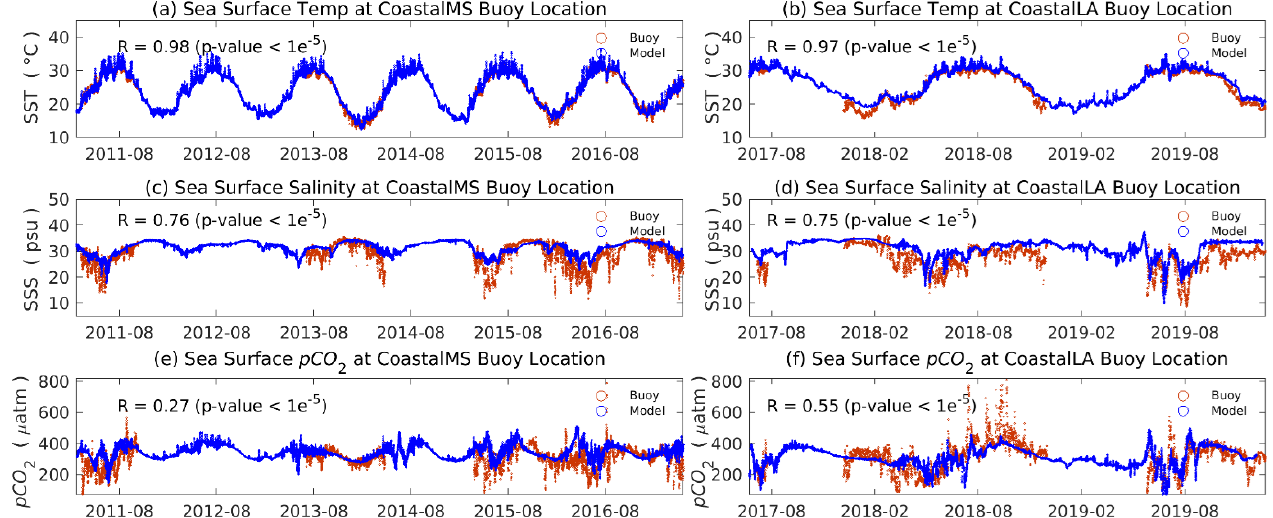
Figure 4. Time series of SST, SSS, and p CO 2 _sea at sites CoastalLA and CoastalMS.